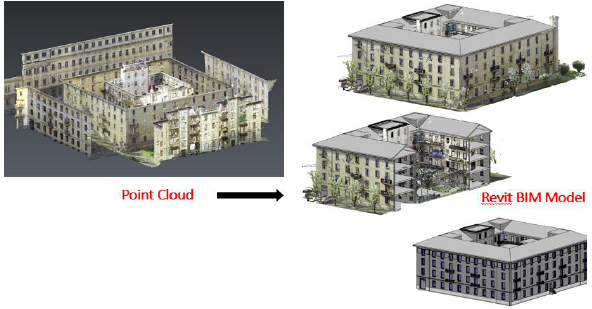
Figure 5. Process of modelling from point cloud to BIM model.